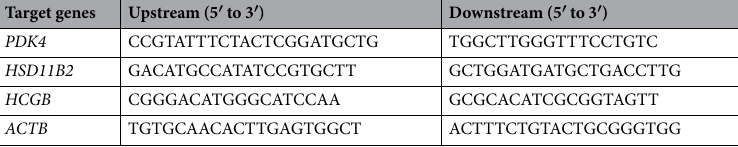
Table 2. Primer sequences for